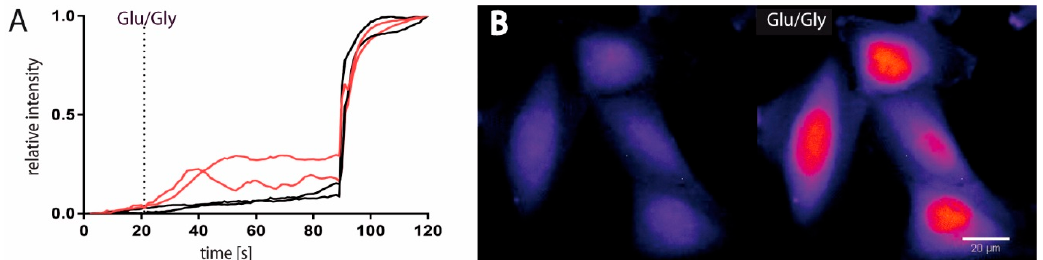
Figure 1. Cont . Figure 1.